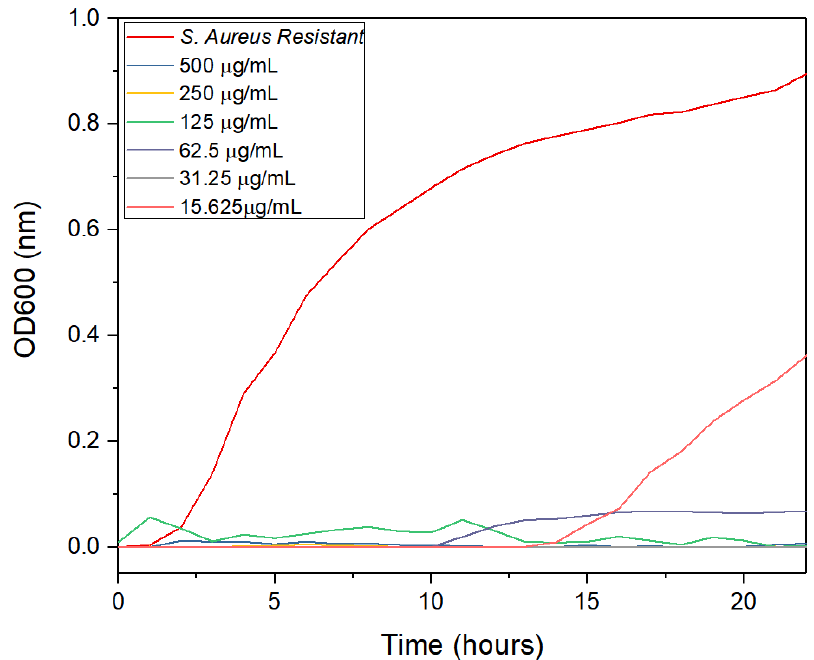
Antibiotics 2023 , 12 , x FOR PEER REVIEW Figure 11. Antimicrobial activity of the AgNPs synthesized with lemon peel extract at different times.